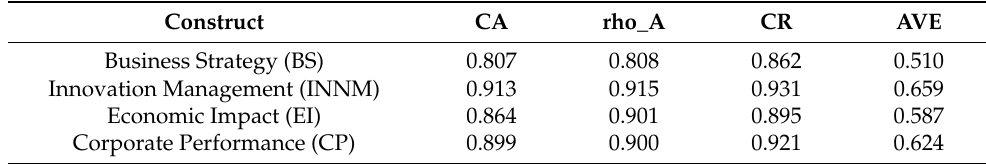
Table 1. Reliability and validity of the constructs.